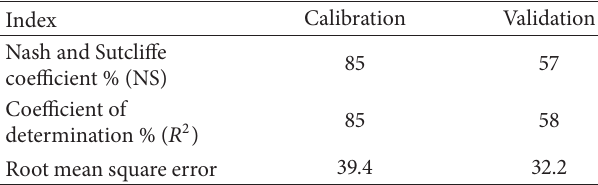
Table 5: Examining indices for accuracy of FF-MNN model.